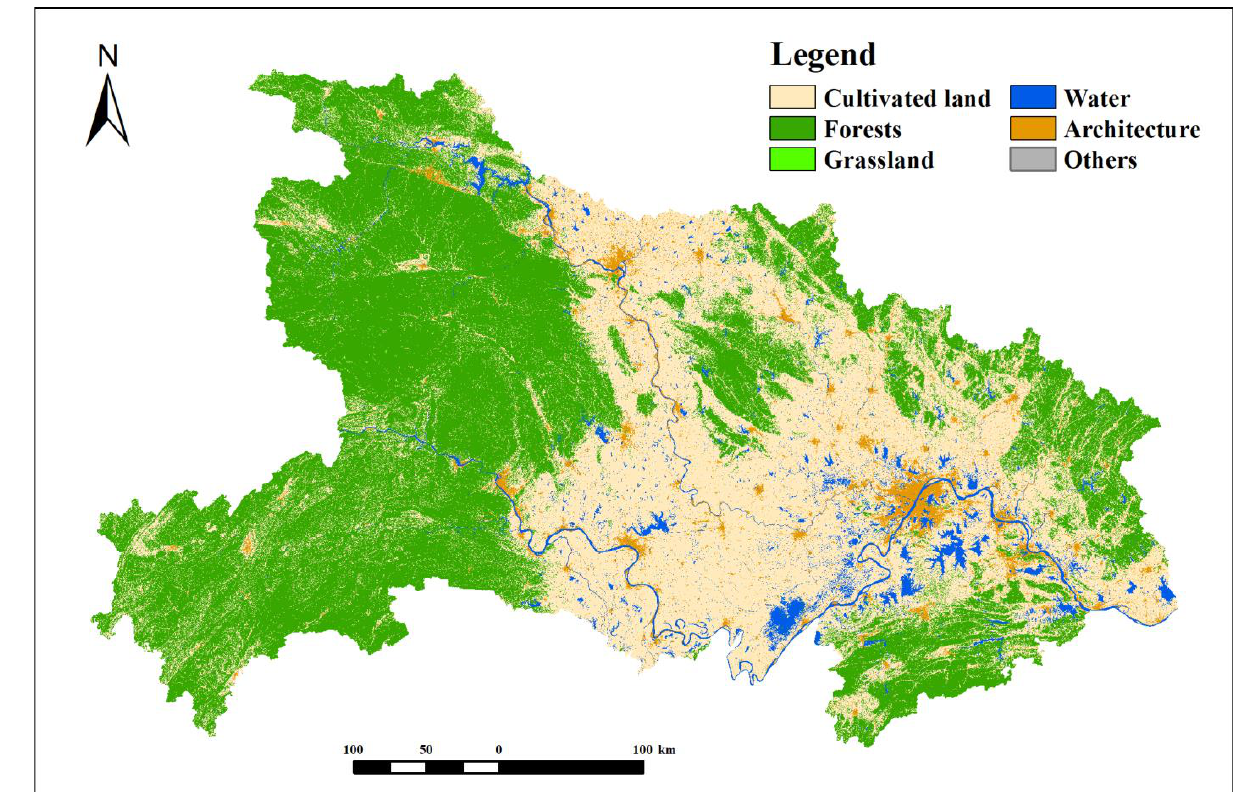
Figure 12. Simulation results for land use in 2035 in the ecological protection scenario.